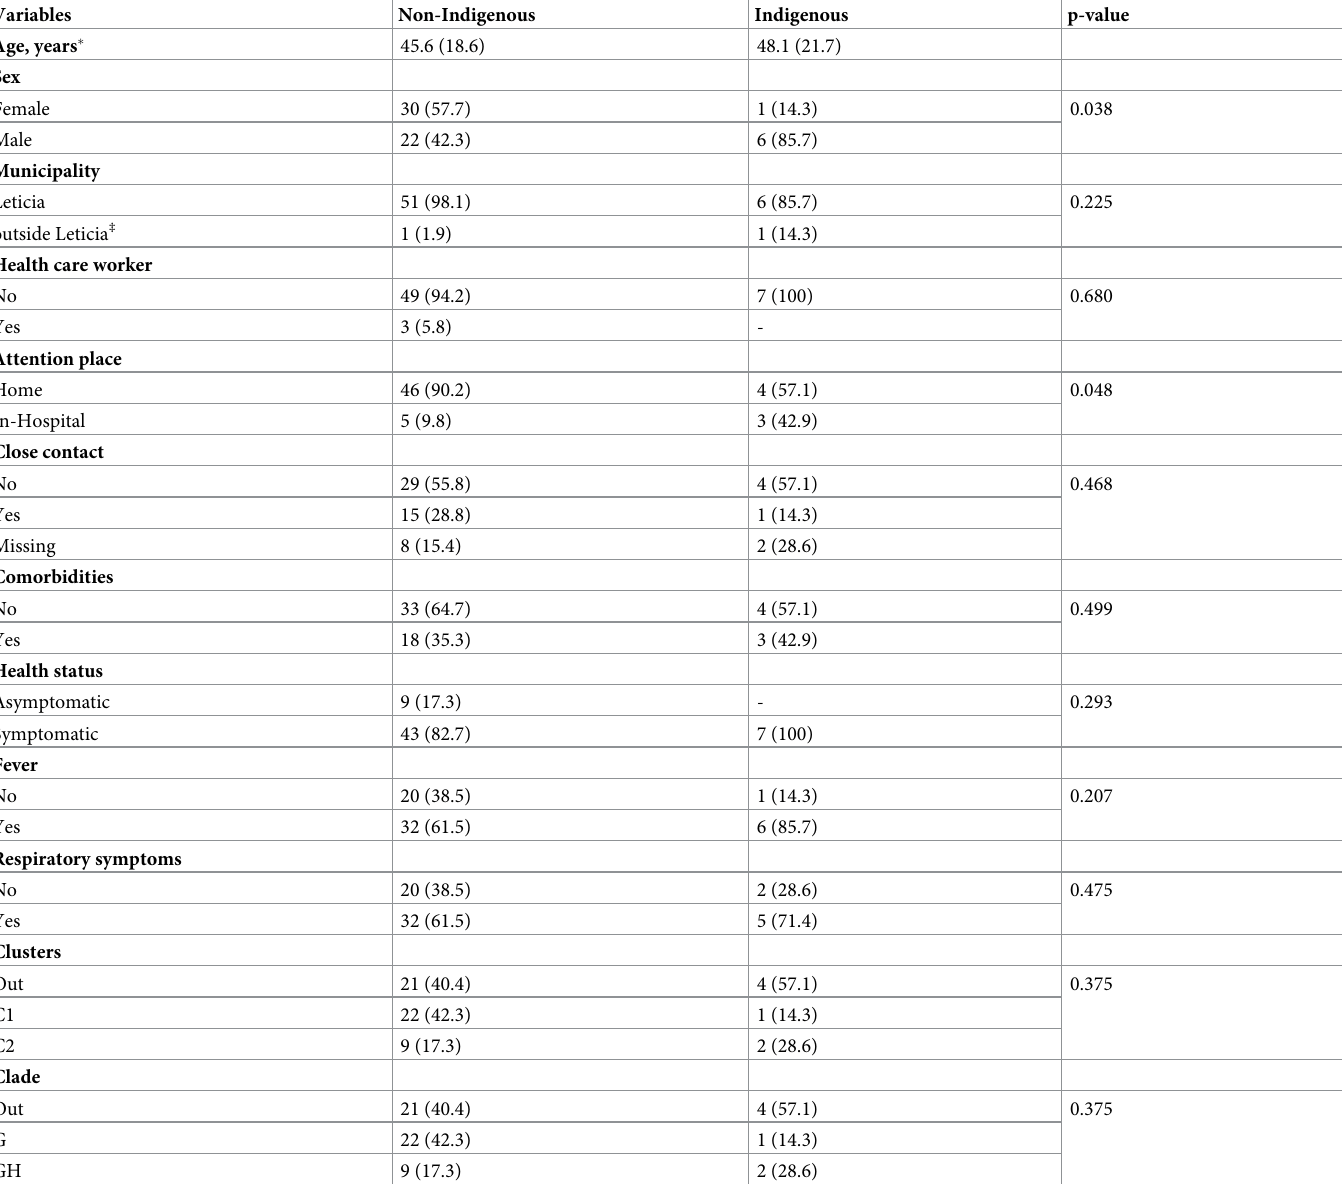
Table 1. Metadata of the SARS-CoV-2 positive patients (n = 59) sequenced in this study, discriminated by ethnicity.